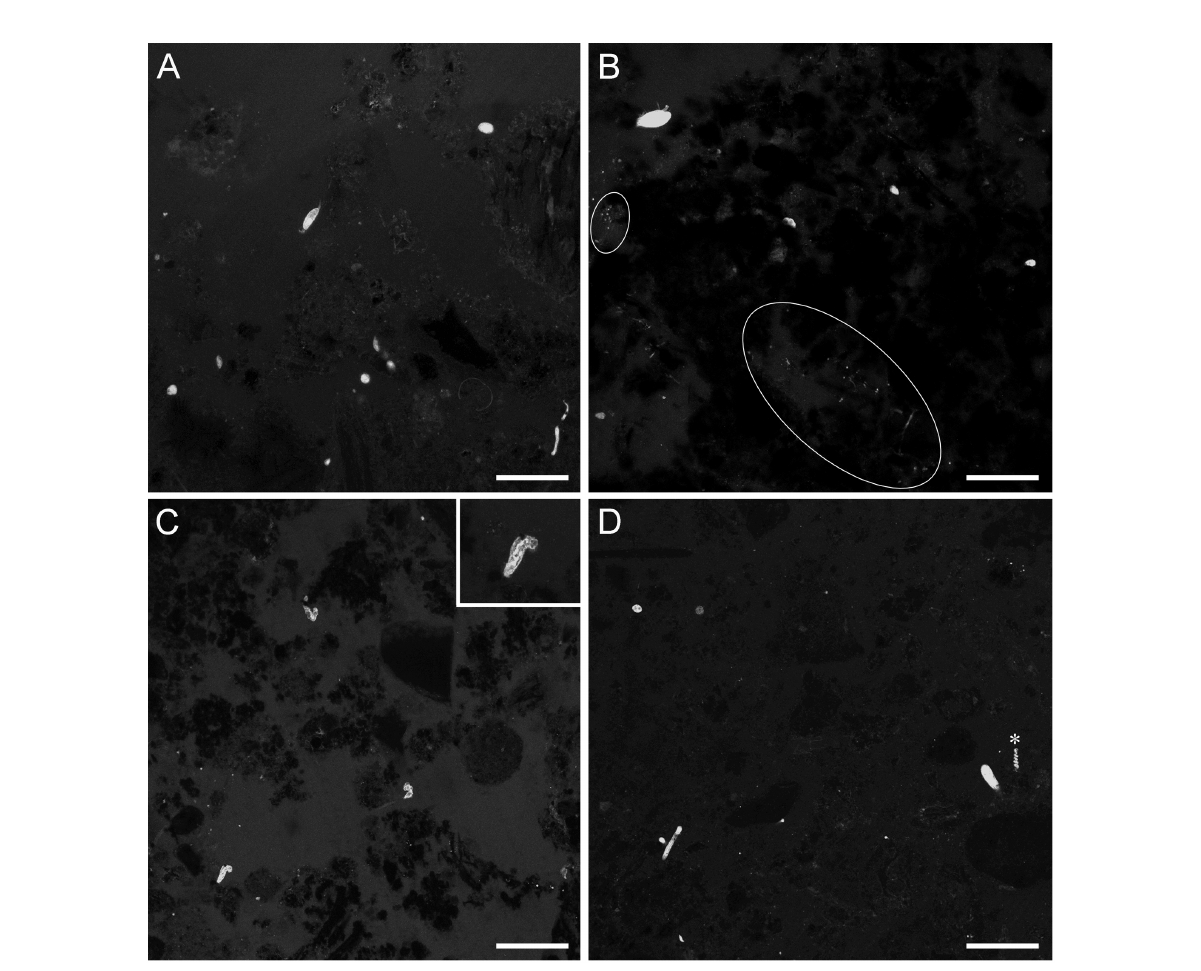
FIGURE 4 LSCM images (z-stacks) of FLEC sections showing overview examples of chimney-base sediments with inhabitants. (A) Core 5 showing mixed community of protists and metazoans, ~1mm depth. (B) Core 4, ~2 mm depth. (C) Core 19 showing three ciliates of similar morphology, ~2 mm depth; Inset in C shows higher magni fi cation view of one ciliate in C. (D) Core 8, ~2 mm depth. White ovals highlight areas with aggregated microbes, * Turritellella -like foraminifer. Number of images compiled/distance between images (µm): A=43/0.7; B=31/0.7; C= 20/1.4; D=20/1.4; Scales: A,B = 100 µm; C,D = 200